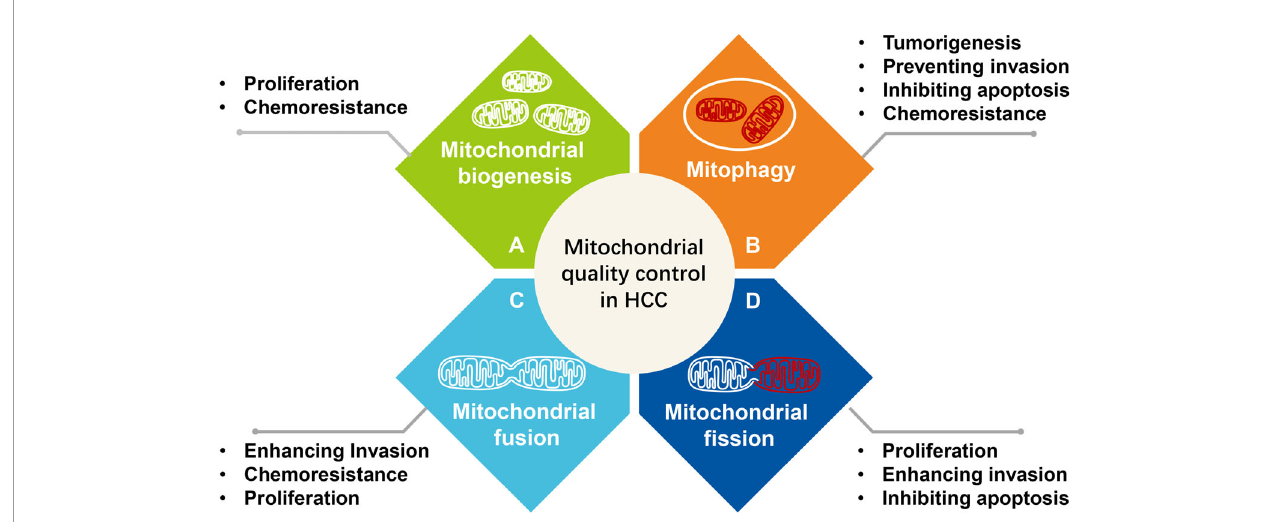
FIGURE 3 | The effect of mitochondrial quality control at the organelle level on the survival and progression of hepatocellular carcinoma. (A) Mitochondrial biogenesis, (B) Mitophagy, (C) Mitochondrial fusion, (D) Mitochondrial fi